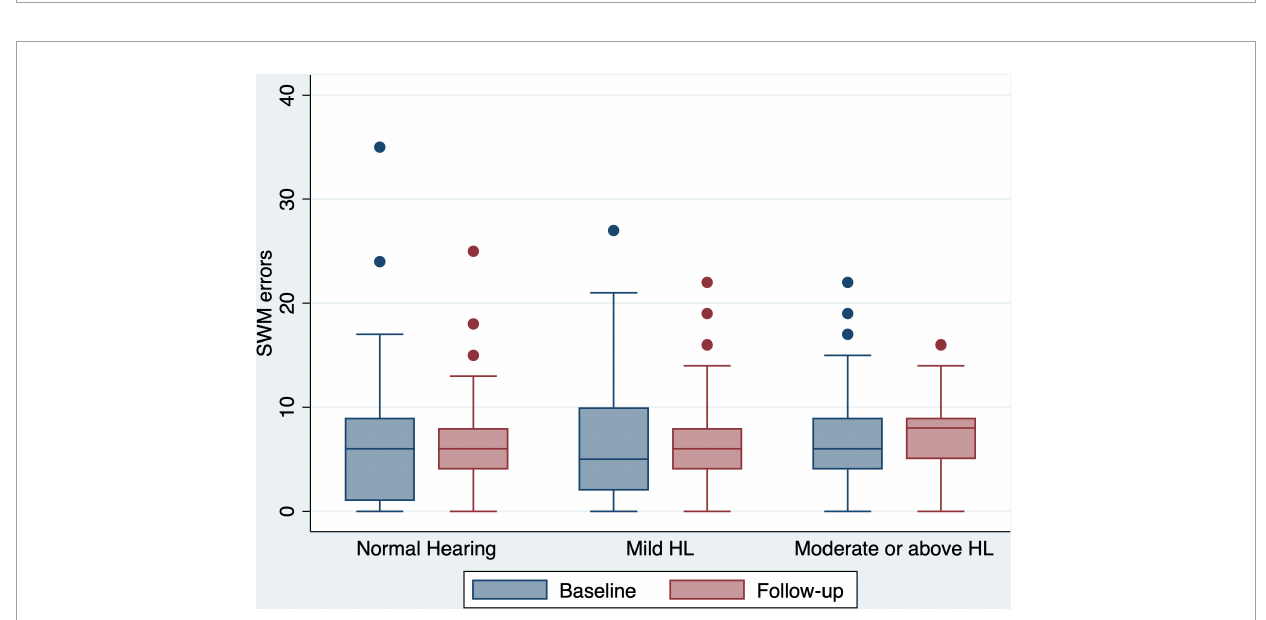
FIGURE4 Box and whisker plot of SWM errors and quartiles at baseline and follow-up, according to the HL categories. Any outlier at baseline/follow-up is shown by a dot. SWM, spatial working memory; HL, hearing loss.